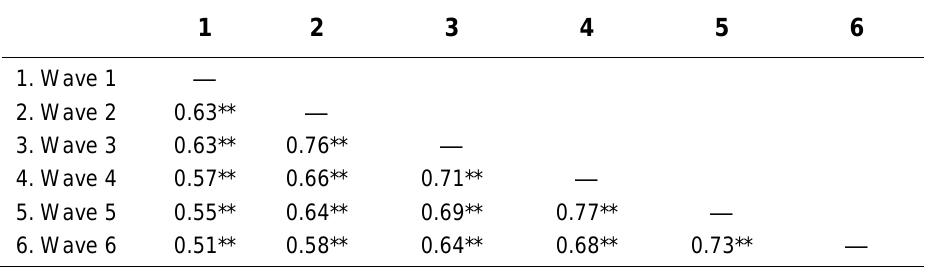
Correlations of the KEY 36 Indicator across Measurement